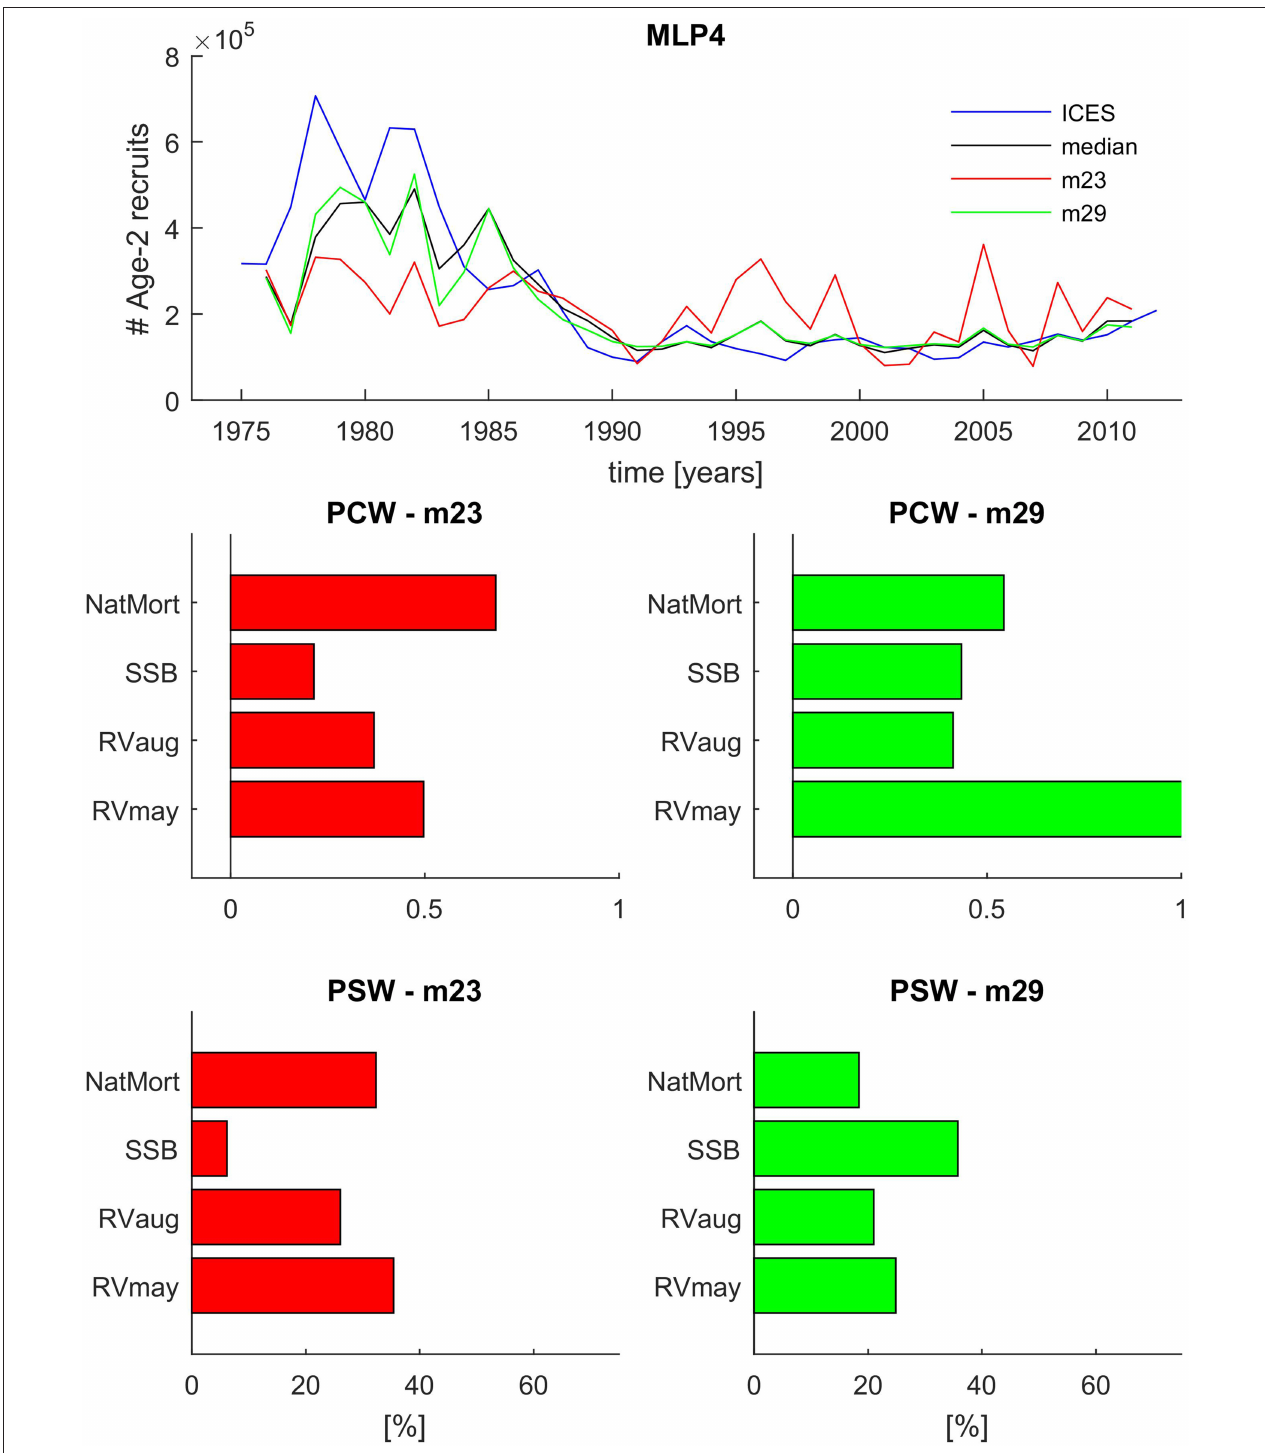
FIGURE 8 | Comparison of the ensemble median and two selected ensemble member model recruitment time series predictions and variable importance estimates from the MLP4 model ensemble. Top panel : time series comparison between the ICES reference values (blue line), the ensemble median (black line), and two selected ensemble member models (m23, red line; and m29, green line) representing extreme ends of the ensemble prediction range. The two Bottom panels show the PCW and PSW variable importance estimates for the m23 ensemble member (left) and the m29 ensemble member (right).